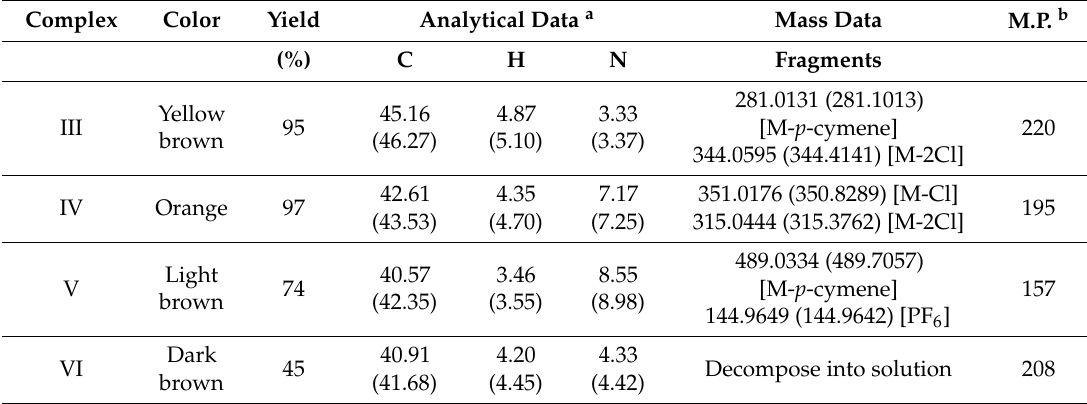
Table 1. Color, yield, analysis, exact mass and melting point (M.P.) for complexes III–VI. (a. calculated values in parenthesis; b. decomposition temperatures from the thermogravimetric curves.).